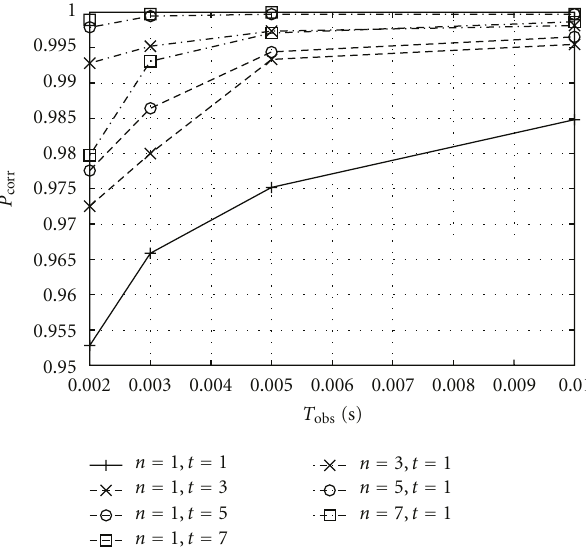
Figure 6: Probability of correct detection P corr versus energy per bit to noise power spectral density ratio E b /N 0 for di ff erent numbers n of cooperative single antenna CR terminals and multiple antenna CR terminal with a variable number t of antennas.